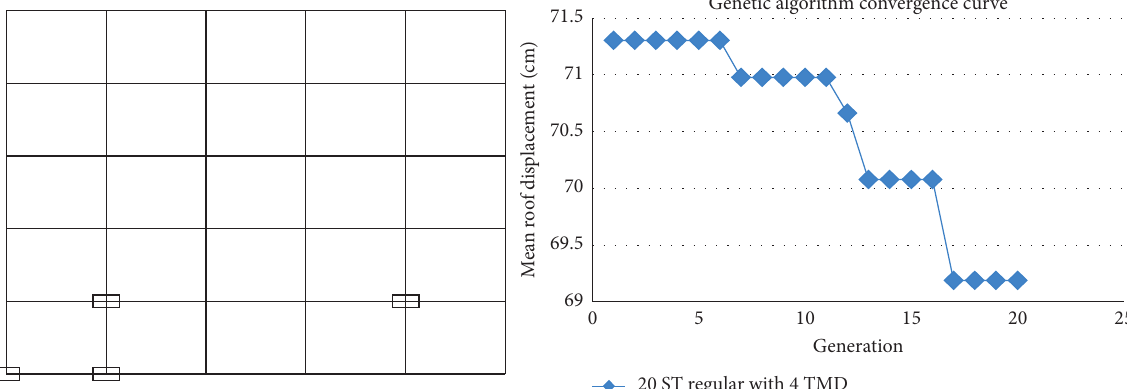
Figure 26: Convergence diagram of the twenty-story model with 4 dampers in genetic algorithm (right) and damper optimal positions (left).